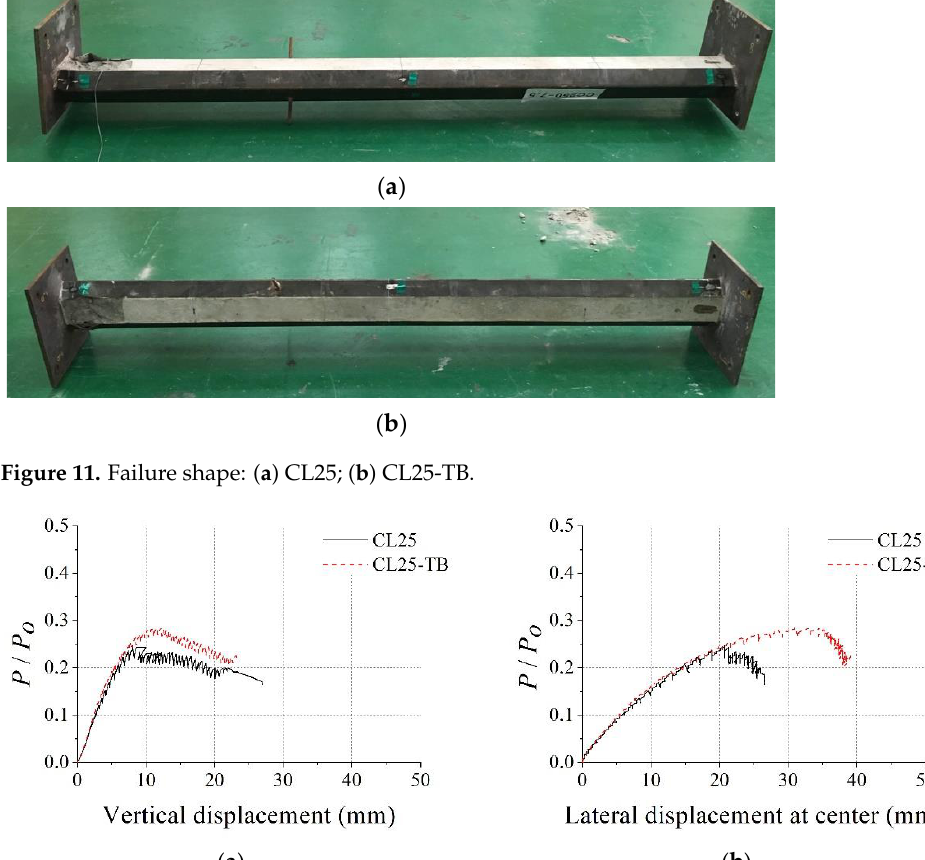
Figure 12. Test results for CL25 and CL25-TB: ( a ) dimensionless axial load vs. vertical displacement; ( b ) dimensionless axial load vs. lateral displacement at the center.